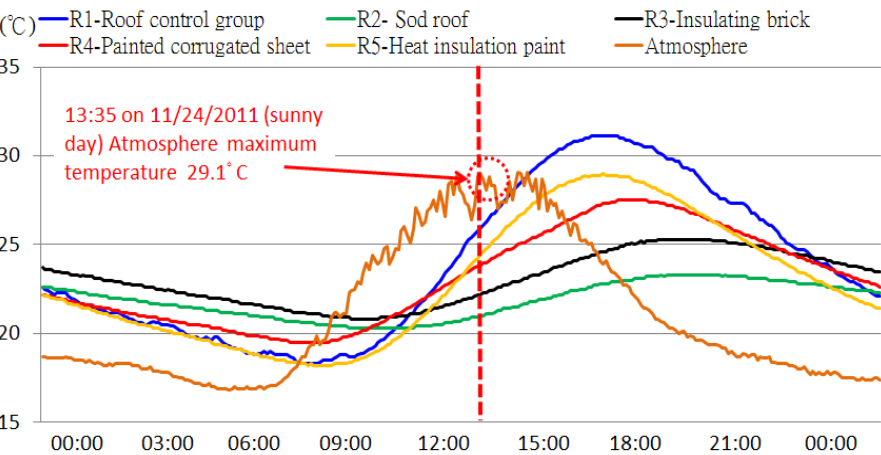
Figure 10. The effect of roof thermal insulation materials on heat-storing properties of